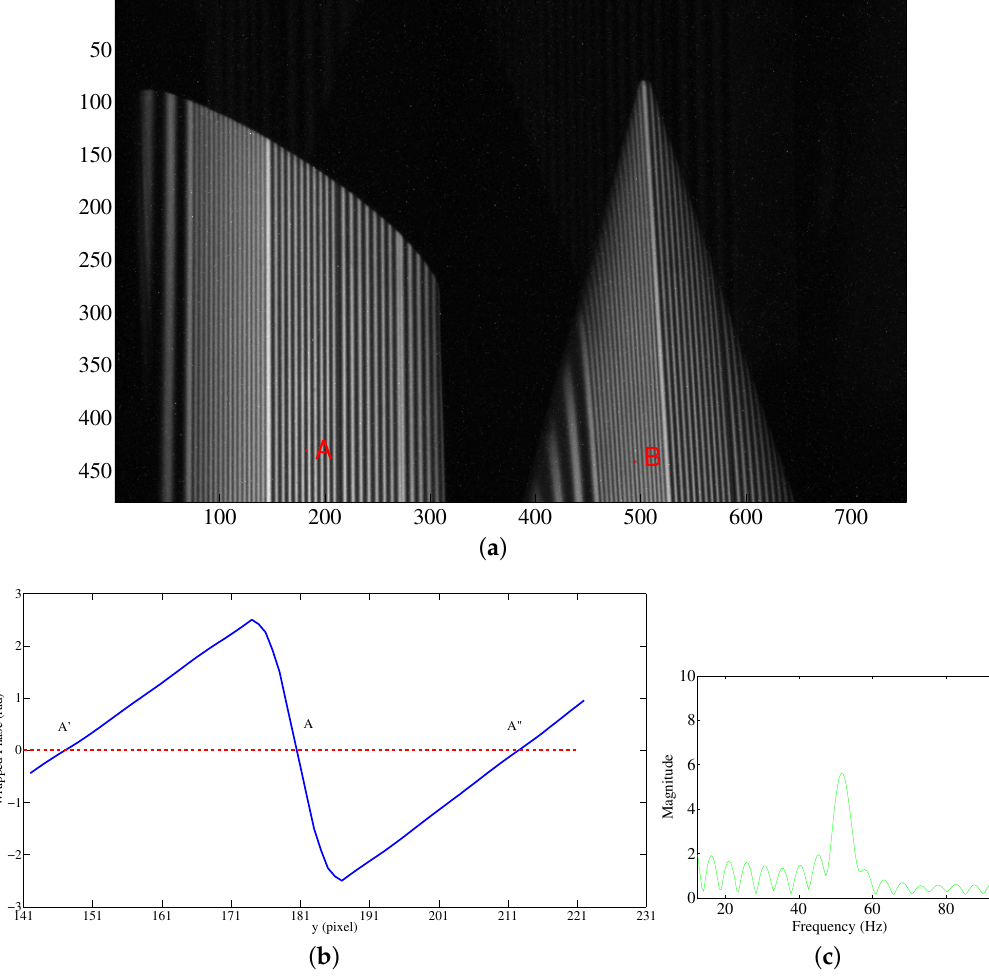
Figure 13. Absolute phase map retrieval for spatially isolated objects. ( a ) Captured designed fringe pattern for multiple discontinuous objects; ( b ) graph for finding the phase zero-crossing points that include the chosen feature point; and ( c ) frequency component obtained by an FFT.